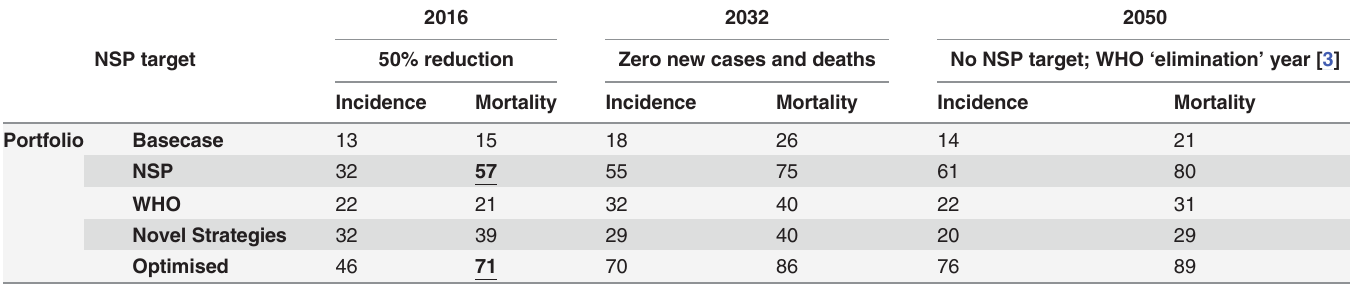
Table 2. Percentage reduction in TB incidence and mortality in each portfolio compared to 2012